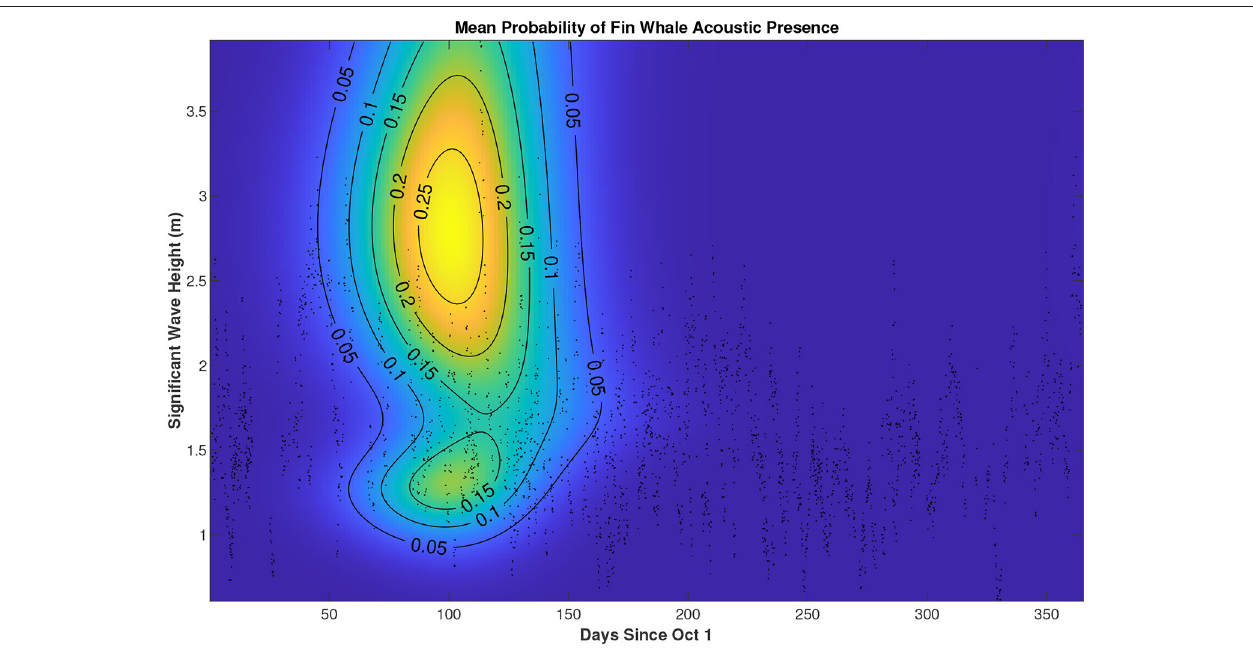
FIGURE 8 | Predicted mean probability of fin whale acoustic track presence as a function of significant wave height and days since October 1 of each song season. Predictions are obtained from our best model, which models acoustic presence as a function of song season, and both the marginal and interaction effects of wave height and days since October 1. This plot holds song season constant at 2015–2016; other song seasons show the same pattern but different absolute probability values. Data from all years are shown in the background scatter plot (i.e., 3 h time bins with acoustic recordings and wave height measurements). The shape of these results in relation to wave height should not be over-interpreted as there is low data density over much of the